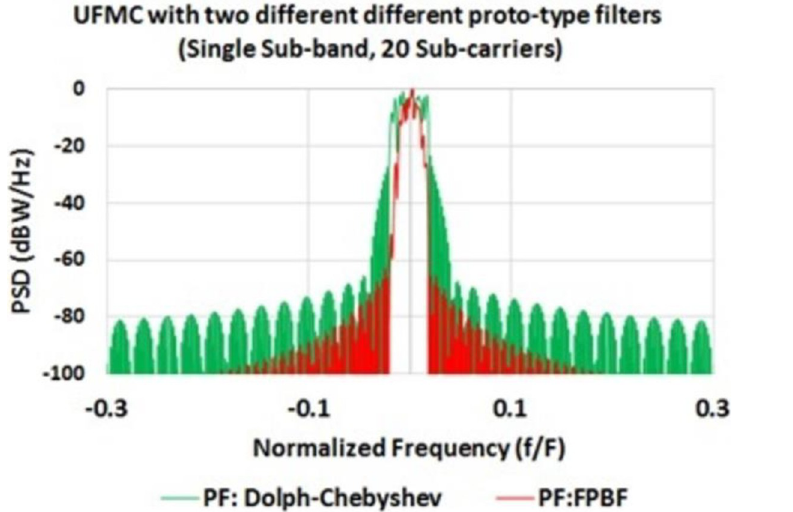
Fig 9. PSD of FPBF based UFMC and Dolph-Chebyshev filter based UFMC.